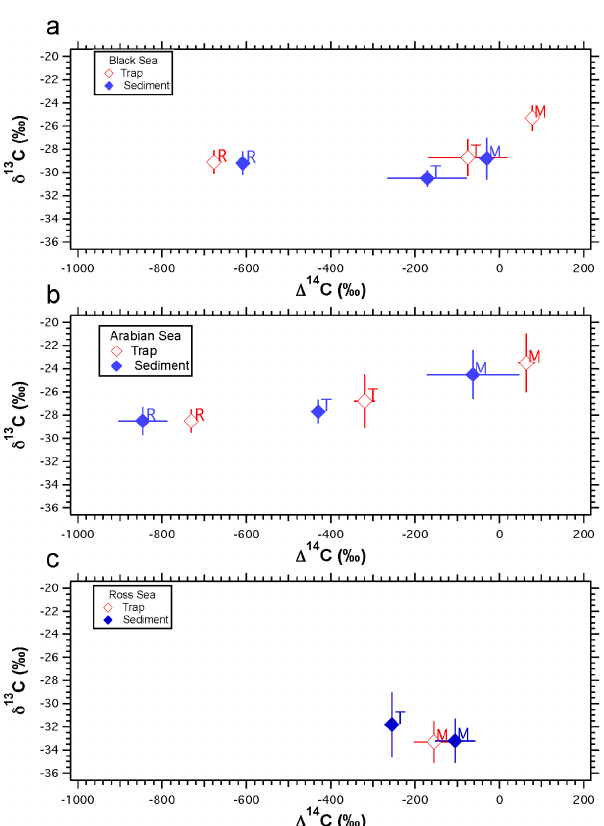
Figure 11. Concentration-weighted average δ 13 C and (cid:49) 14 C values of marine (M), terrigenous (T) and relict (R) lipids in (a) Black Sea, (b) Arabian Sea and (c) Ross Sea traps and